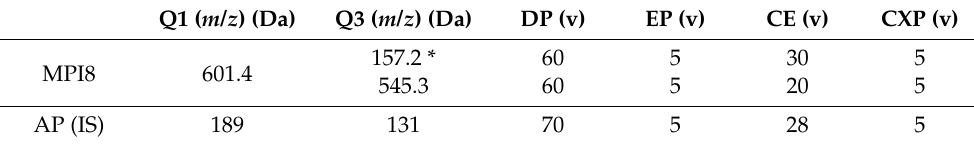
Table 1. Compound dependent parameters for MPI8 and